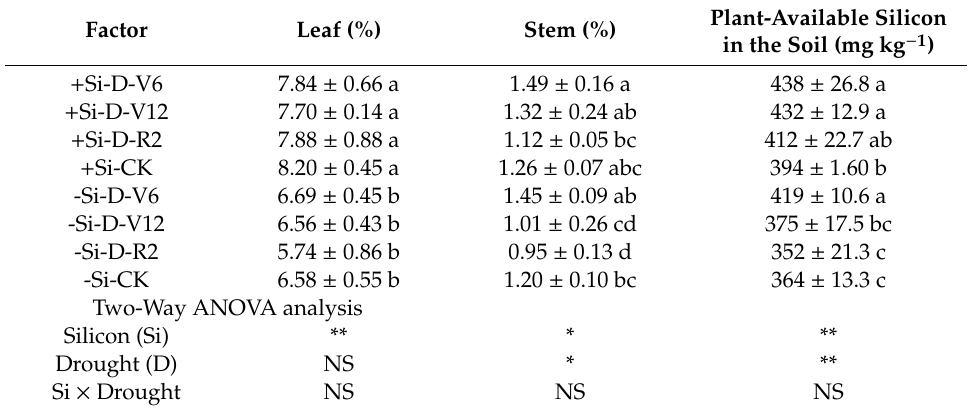
Table 3. Impact of silicon fertilization and drought stress on Si concentration in maize plants and soil.